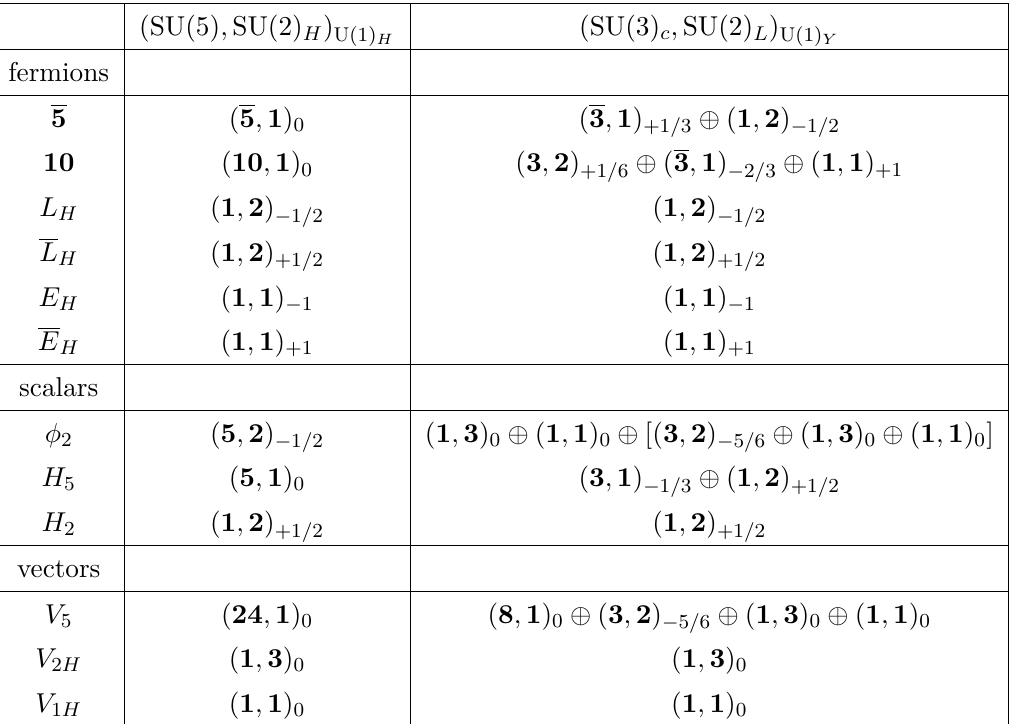
Table 1. The content of the fermions, the scalar fields and the gauge bosons in the SU(5) × U(2) H model is shown in the group representation, (SU(5) , SU(2) H ) fermion has three generations. The U(1) Y neutral scalar fields and gauge bosons are given by the real scalar fields and real gauge bosons. The scalar fields enclosed in square brackets are the Goldstone modes associated with SU(5) × U(2) H breaking to G SM , which are eaten by the gauge